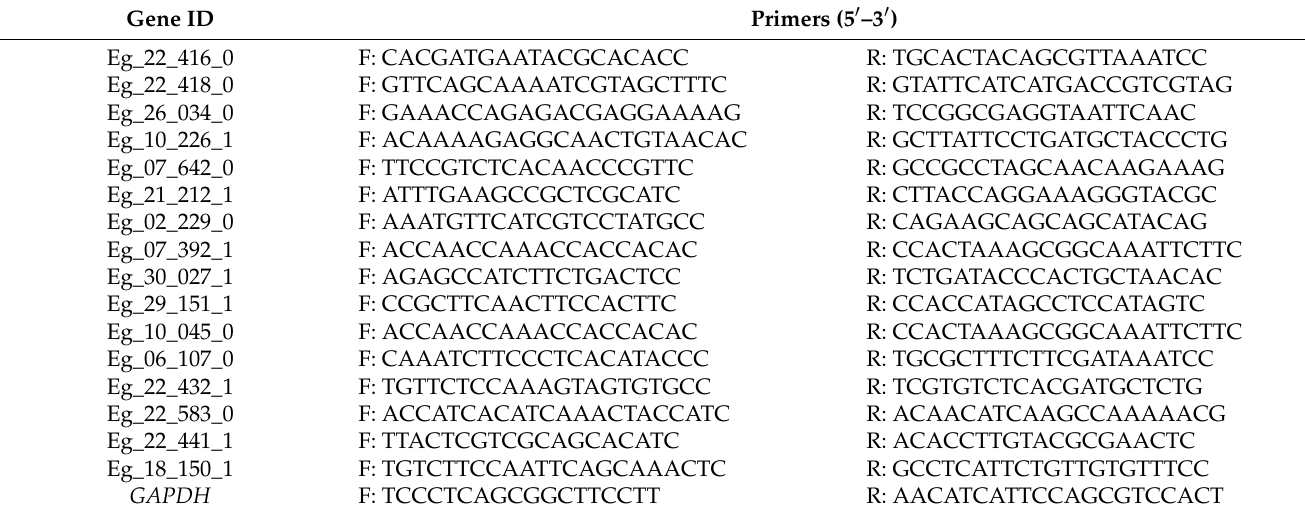
Table 1. Primer sequences for quantitative